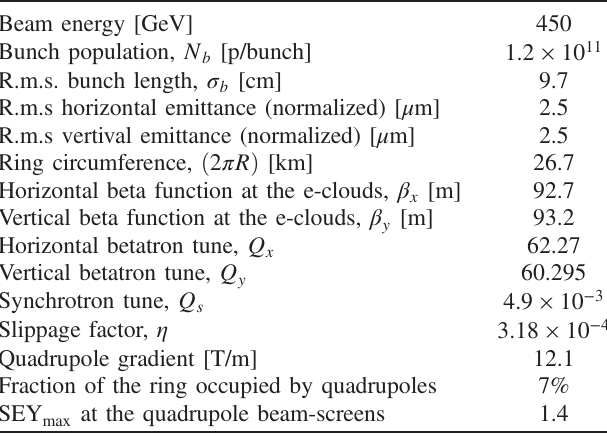
TABLE I. Main parameters for the considered LHC scenario.